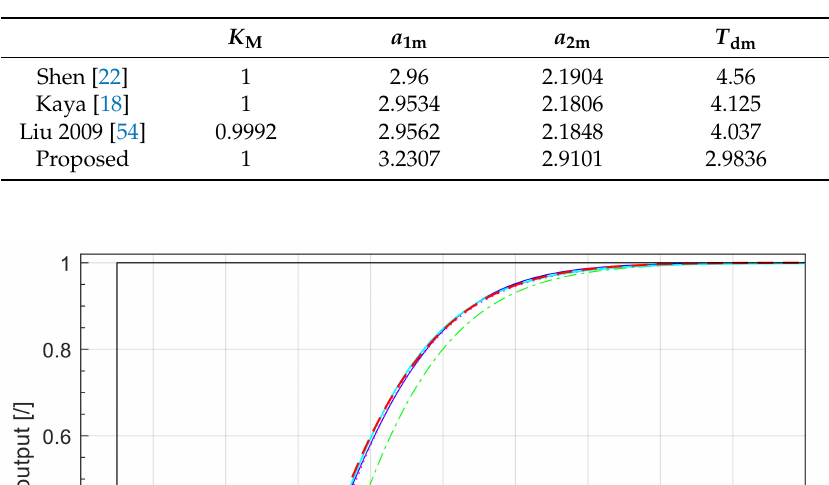
Table 12. The estimated model parameters for the process G P6 .